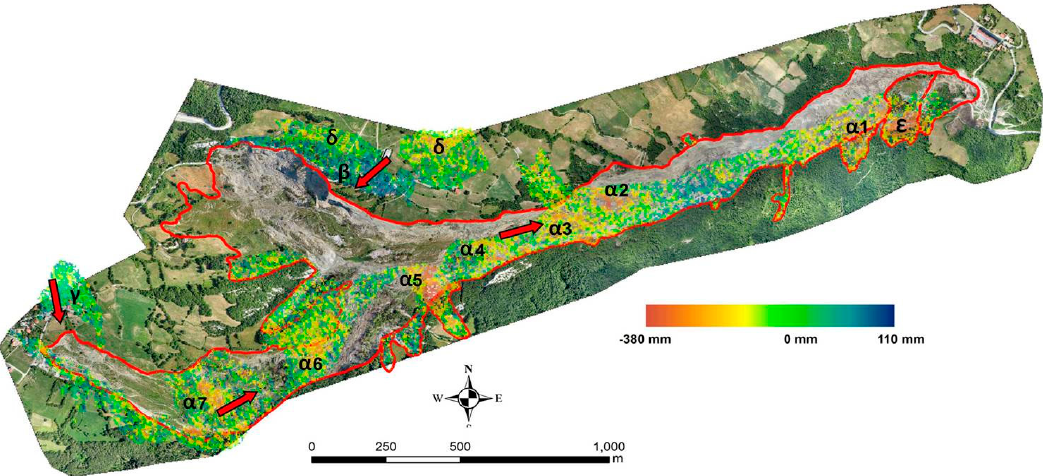
Figure 10. Cumulated displacements (mm) detected along the GB-InSAR LOS from 19 July 2013 to 31 December 2014. Letters indicate the different sectors identified in the observed scene. Arrows indicate the main displacement directions.